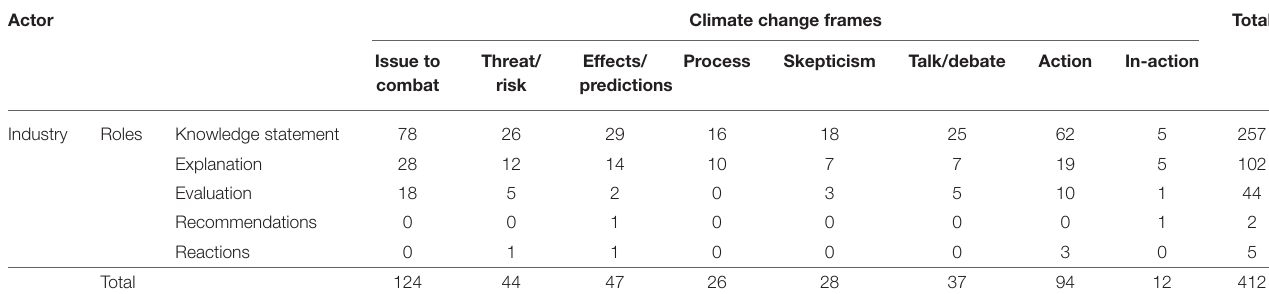
TABLE 5 | The roles of industry actors by